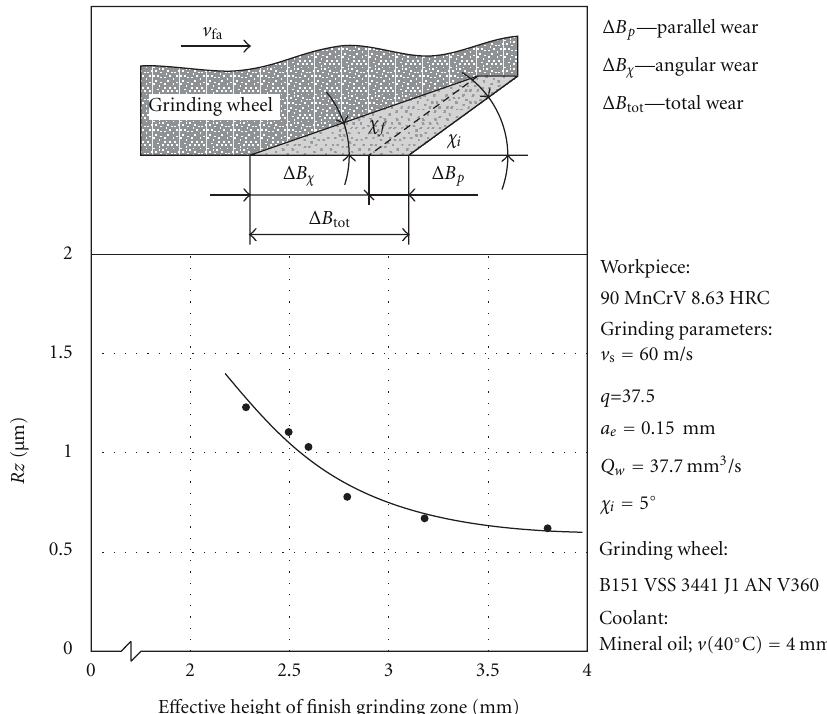
Figure 5: Forms of the grinding wheel active surface edge wear occurring in the course of single-pass grinding using grinding wheels with a conic chamfer